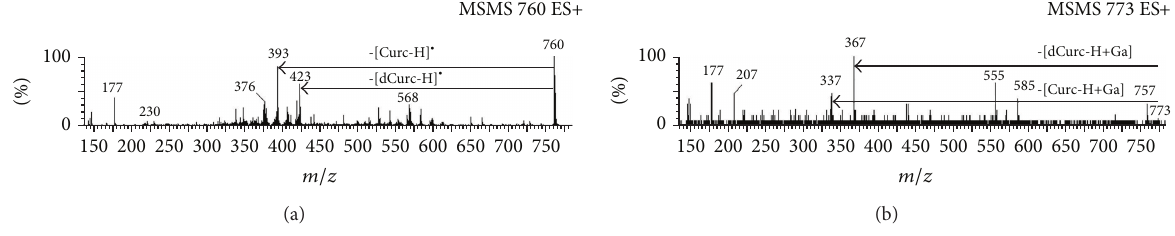
Figure 2: CID-MS/MS spectra of ions [dCurc + Curc-2H + Fe] + ((a) CE = 35 V) and [dCurc + Curc-2H + Ga] + ((b) CE = 50 V).